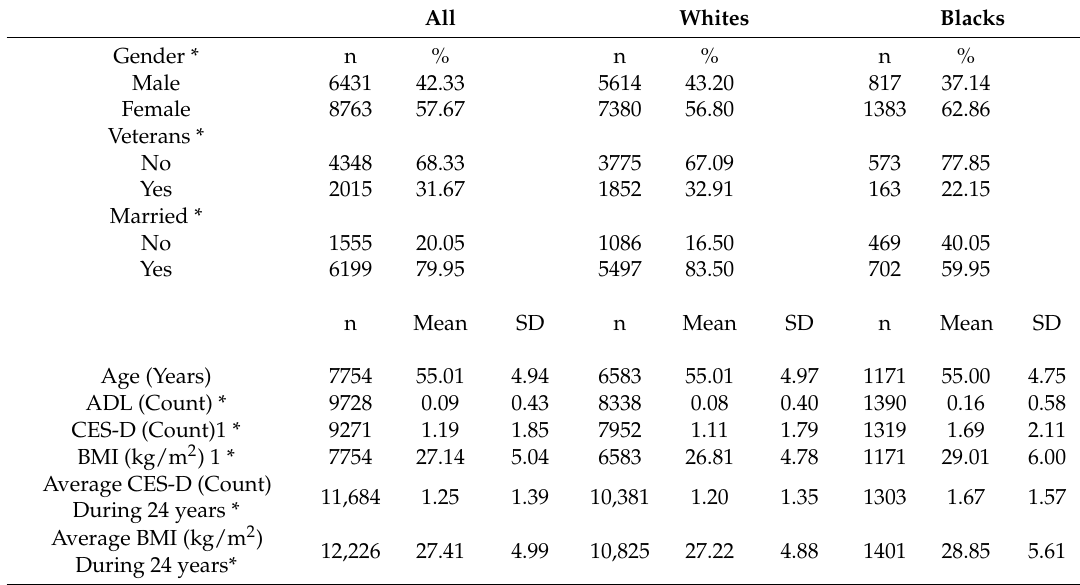
Table 1. Descriptive statistics in the pooled sample and based on race and gender.